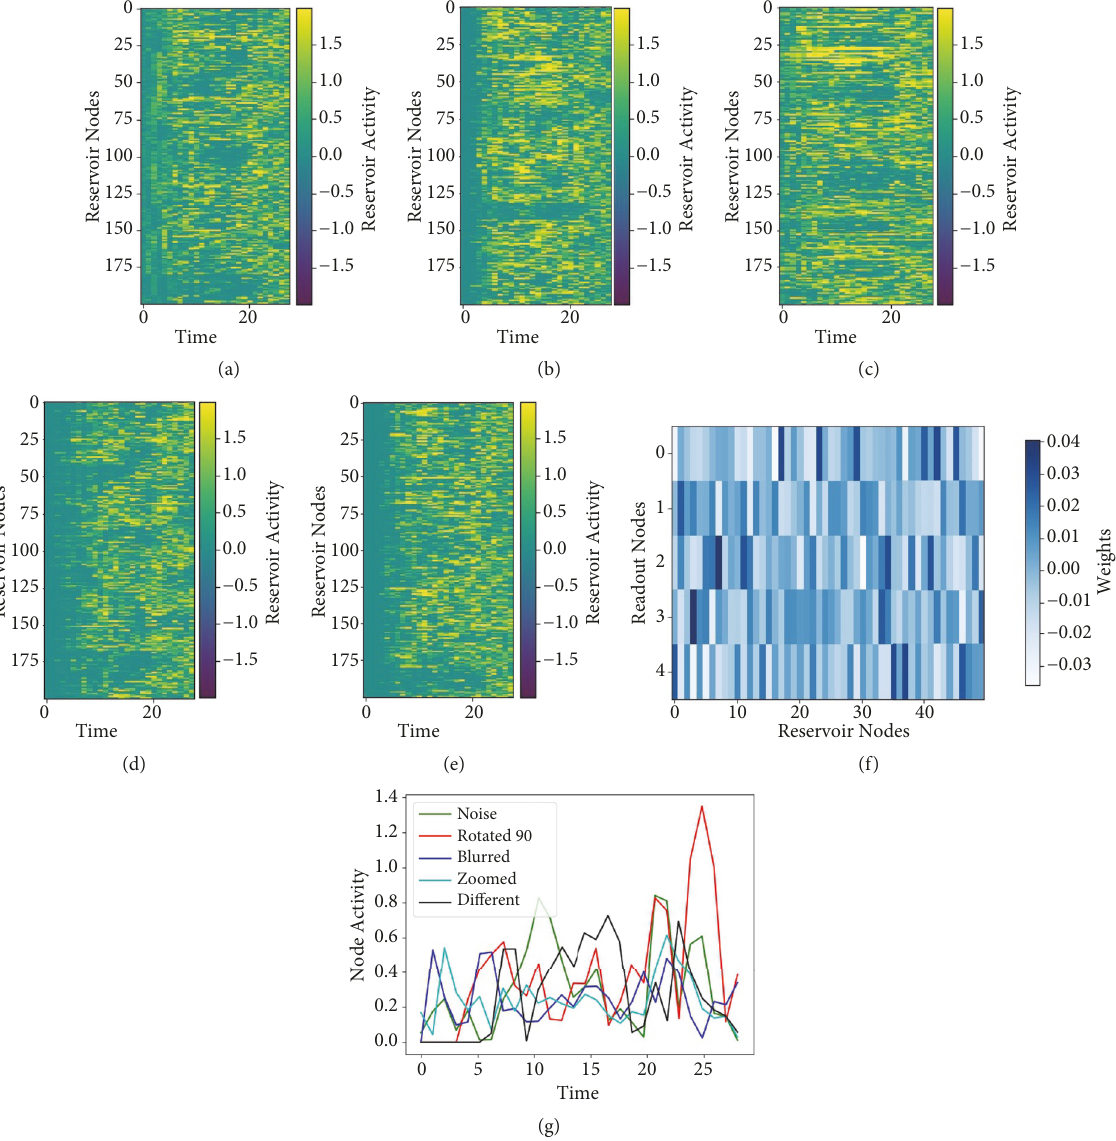
Figure 12: Reservoir activity for the dual reservoir architecture. (a), (b), (c), (d), and (e) show the differential reservoir activity of 200 nodes over 28 timesteps for input relationships noise, rotated, zoomed, blurred, and different respectively. (f) shows the output weight matrix( 𝑊 out ) for 50 reservoir nodes. (g) shows activity of a random node for all output labels over 28 timesteps. 𝑁 𝑅 : 1000; 𝛾 = 0.5 ; sparsity = 0.9 .